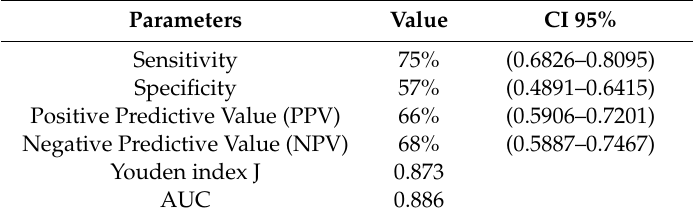
Table 3. Serological reactivity parameters used for the determination of anti- Plasmodium falciparum antibodies by in-house ELISA.